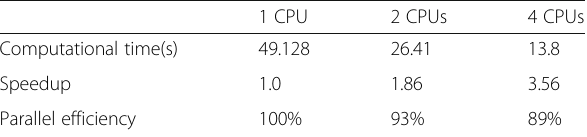
Table 4 Computational time, speedup, and parallel efficiency for airfoil meshes